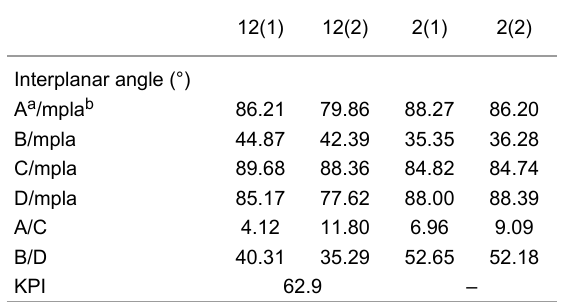
Table 1: Selected conformational parameters of the mixed ether 12 in comparison with the corresponding tetramethoxycalix[4]arene 2 . Pairs (e.g. 12(1) and 12(2) ) reflect two crystallographically independent molecules in these